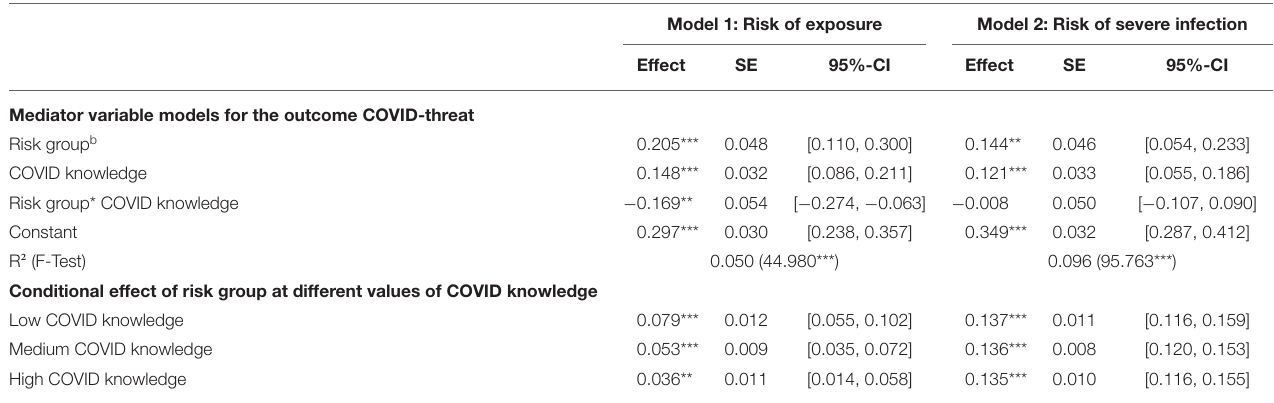
TABLE 3 | Mediator variable models of the conditional mediation model ( N = 4,096) a